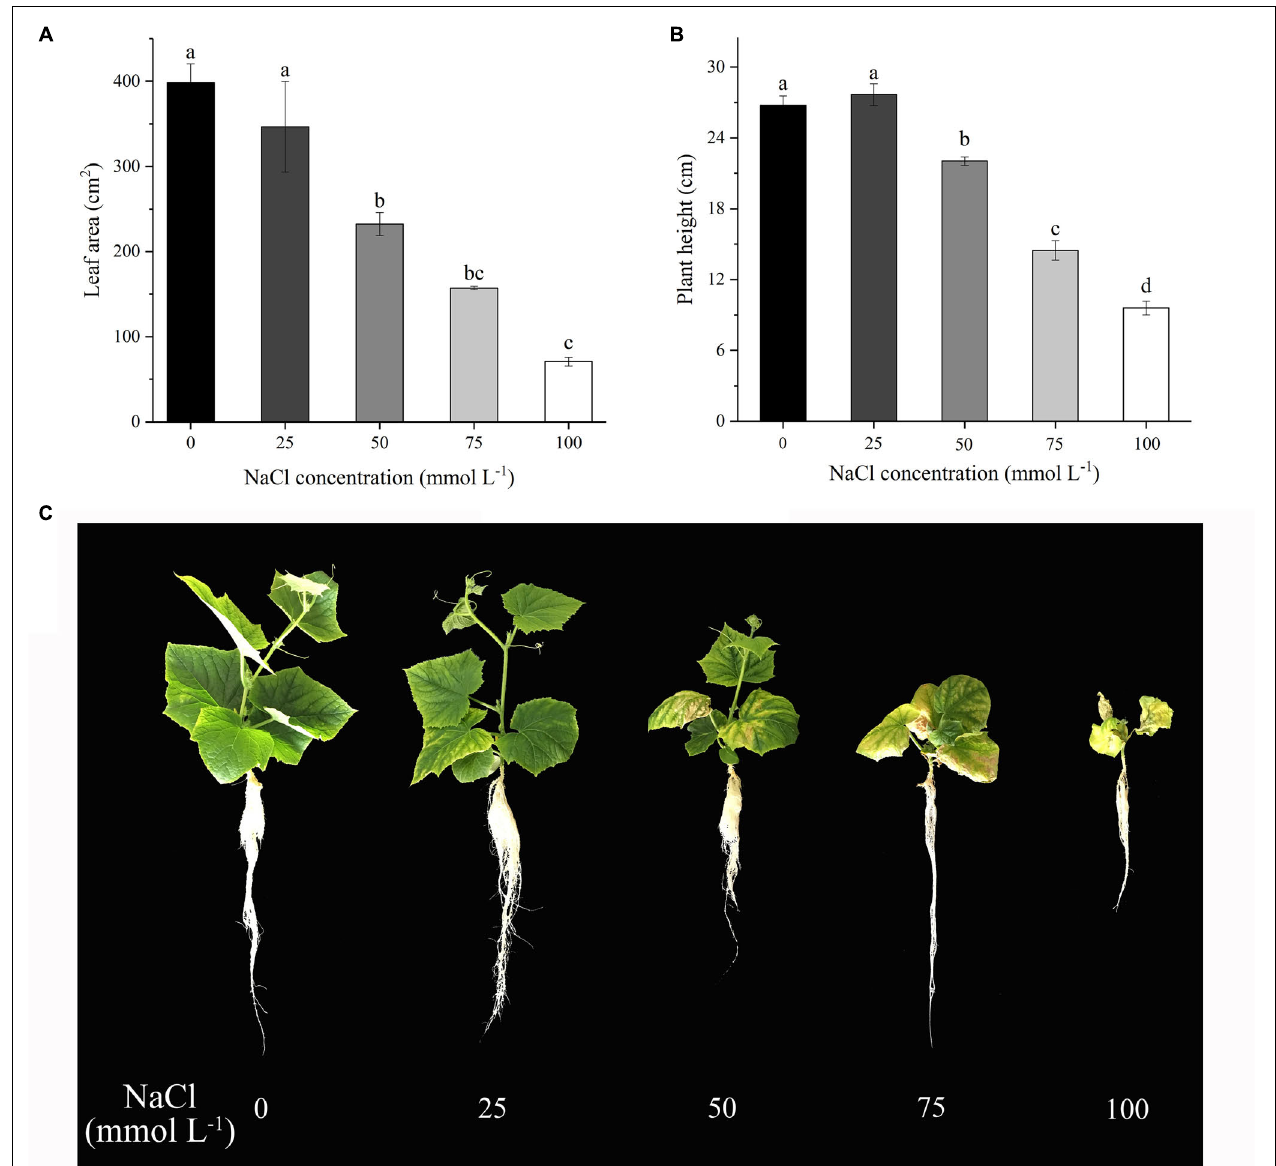
FIGURE 1 | Effects of different NaCl concentrations on leaf morphology and plant height of cucumber seedlings. (A) Leaf area changes of cucumber seedlings under different concentration of NaCl. (B) Plant height of cucumber seedlings under different concentration of NaCl. (C) Morphological changes of cucumber seedlings under various concentration of NaCl, including 0, 25, 50, 75, 100 mmol L − 1 . The data presented were the means of three plants ± SE of means ( n = 3, with 6 plants per replication). Treatment means with different letters indicate significant differences according to Tukey’s test ( p <